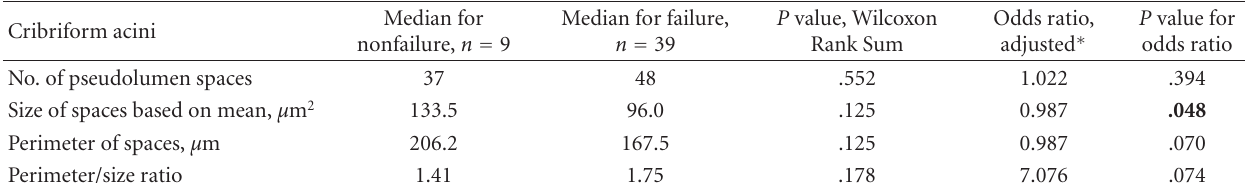
Table 2: Pseudolumen measurements for the cribriform